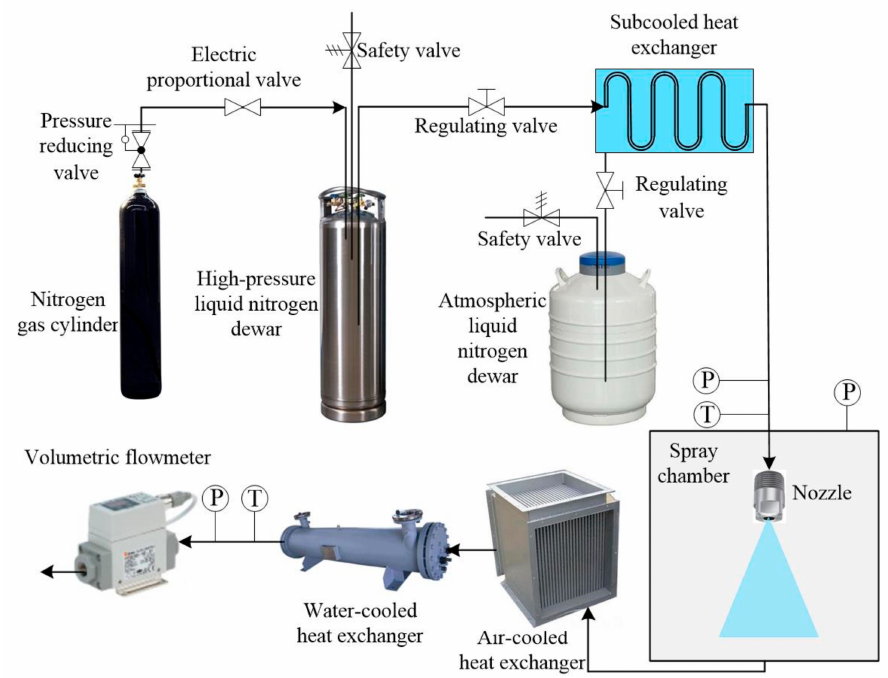
Figure 1. Schematic diagram of mass flow rate measuring